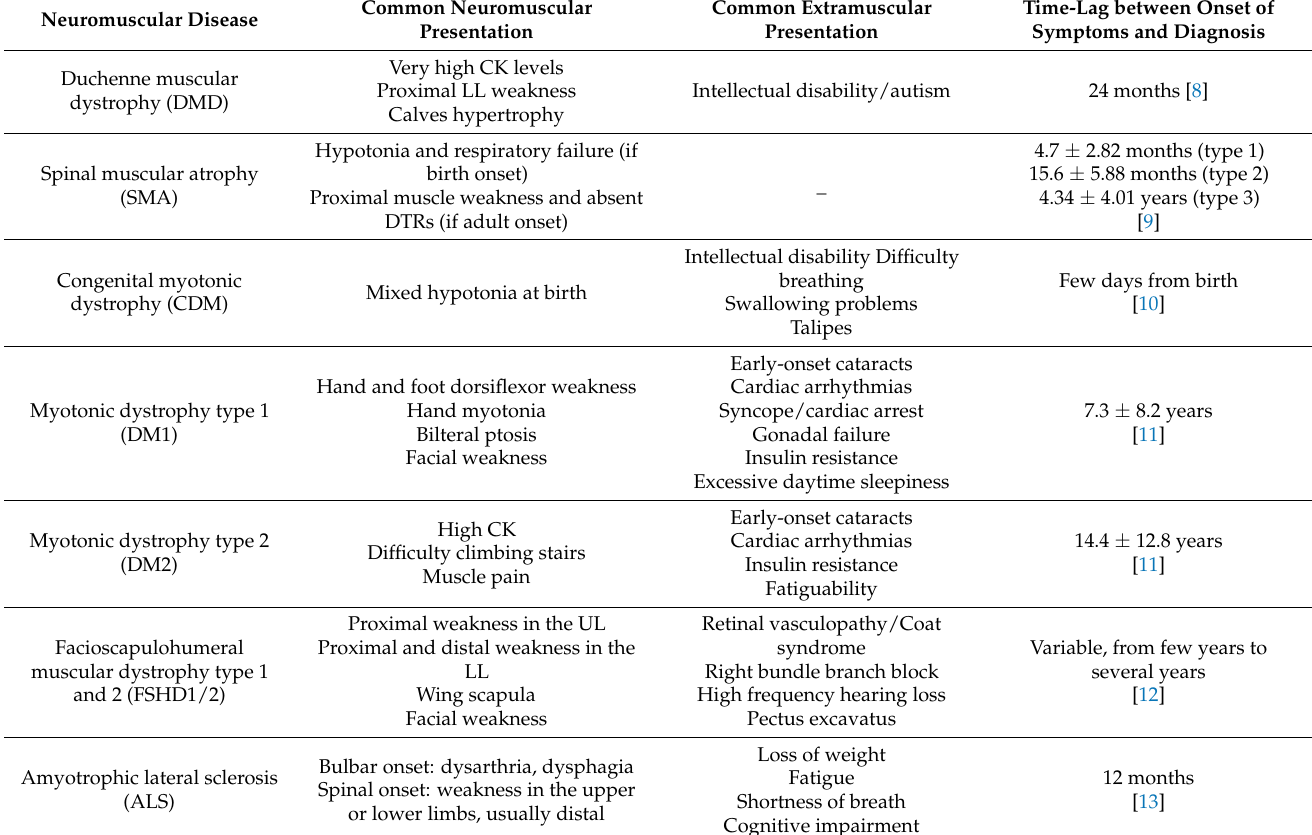
Table 1. Main neuromuscular conditions and time lag between onset and diagnosis. Common Neuromuscular Neuromuscular Disease